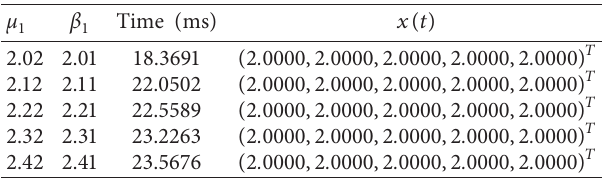
Figure 3: Transient behavior of x ( t ) and u ( t ) of the second-order differential equation system (16) in the example with ρ � 10. Table 1: Convergence time of x ( t ) by the second-order differential equation system (16).